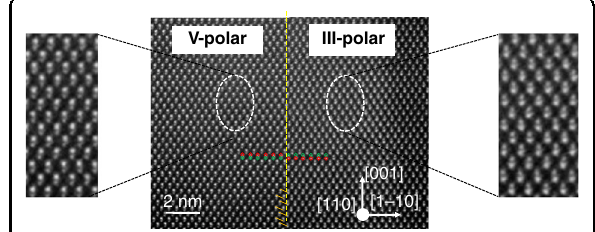
Fig. 2 Scanning transmission electron microscopy high-angle annular dark- fi eld image of a GaSb layer grown on an on-axis (001) Si substrate. The dashed yellow line indicates an APB separating two polar domains. The insets show the Ga-Sb dumbbells in each domain, where the brighter atom is Sb due to its higher atomic number. Adapted with permission from ref. 93 . © John